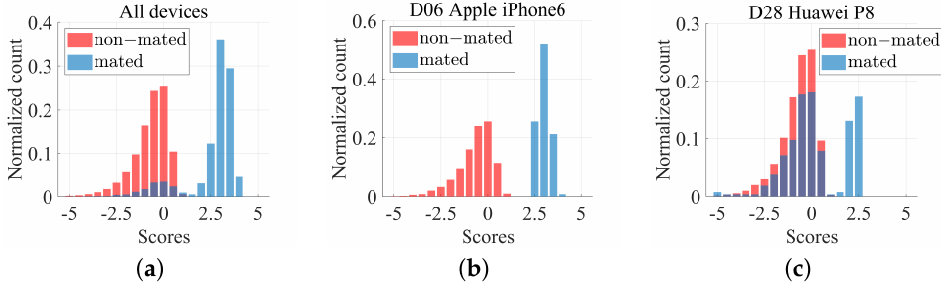
Figure 3. Histograms of empirical score distributions obtained from images. ( a ): empirical distribu- tions by considering all the devices within the benchmark dataset. ( b ): scores obtained from query images coming from an Apple iPhone 6. ( c ): scores distributions for images acquired through a Huawei